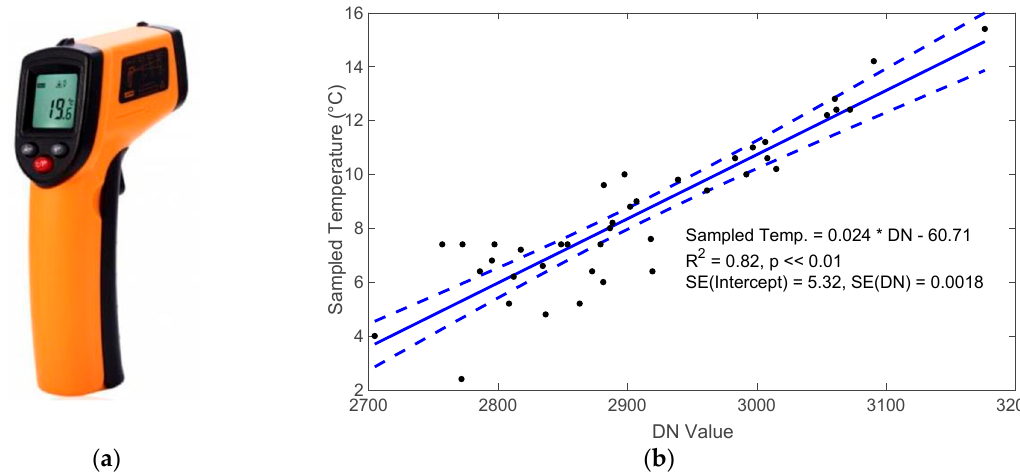
Figure 8. ( a ): Infrared thermometer used to measure temperature of ground objects; ( b ): Linear regression between the sampled temperature of 40 objects and their thermal DN values. Also shown are the regression equation, coefficient of determination (R 2 ), confidence level (p), the confidence interval of the predictions (blue dashed lines), and the standard errors of coefficients (SE).